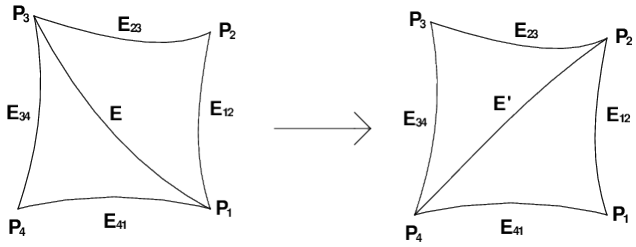
Figure 2. Action of a (cid:13)ip on the quadrilateral Q E